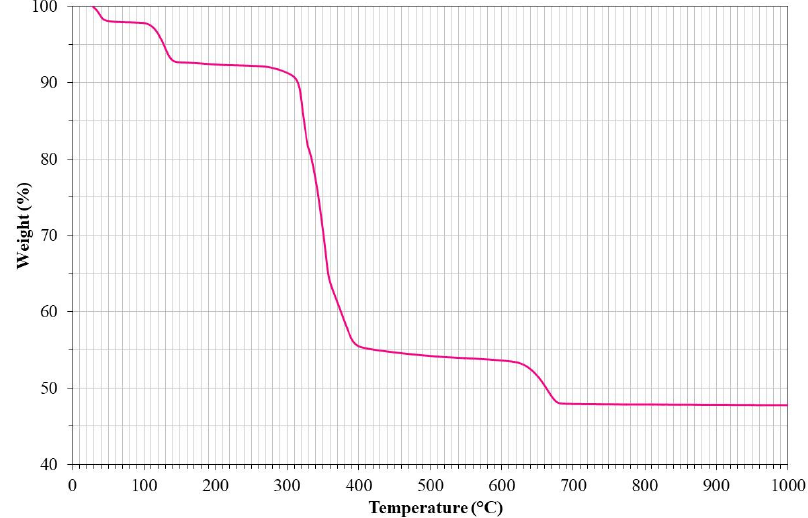
Figure 7. TGA (thermogravimetric analysis) curve of lanthanum acetate in air at a scanning rate of 5 °C/min.